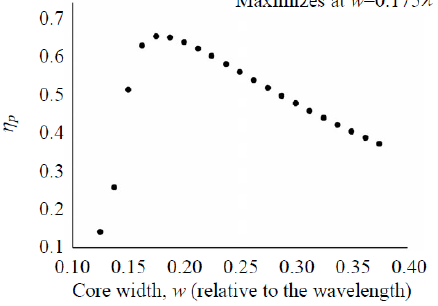
Fig. 3 Values of the parameter  width w in the case of